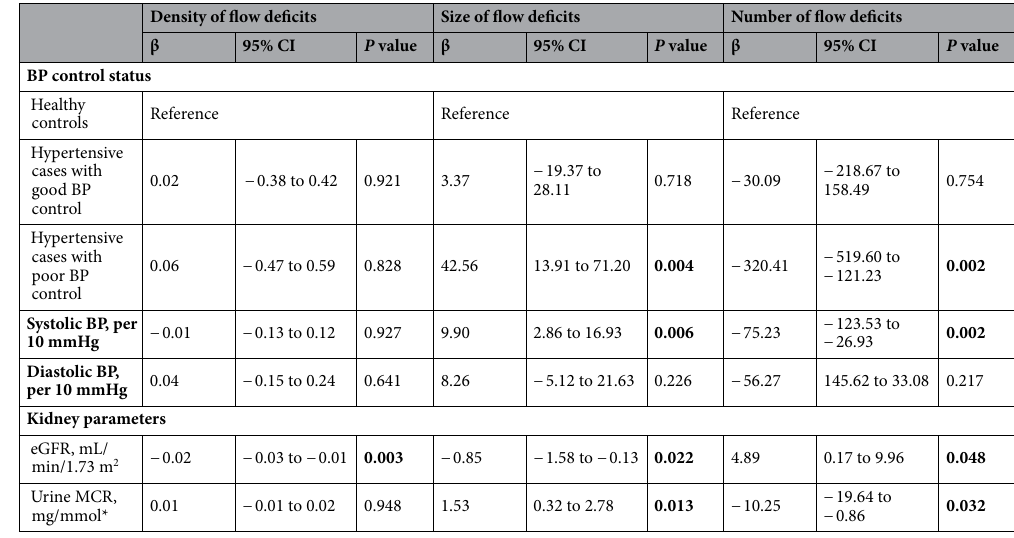
Table 2. Associations of systemic factors with flow deficits metrics (dependent variable). CI confidence interval, BP blood pressure, eGFR estimated glomerular filtration rate, MCR microalbumin-to-creatinine ratio. Bold face indicates statistically significant P value. Adjusted for age, gender, race and body mass index. *Adjusted for age, gender, race, body mass index and systolic blood pressure.